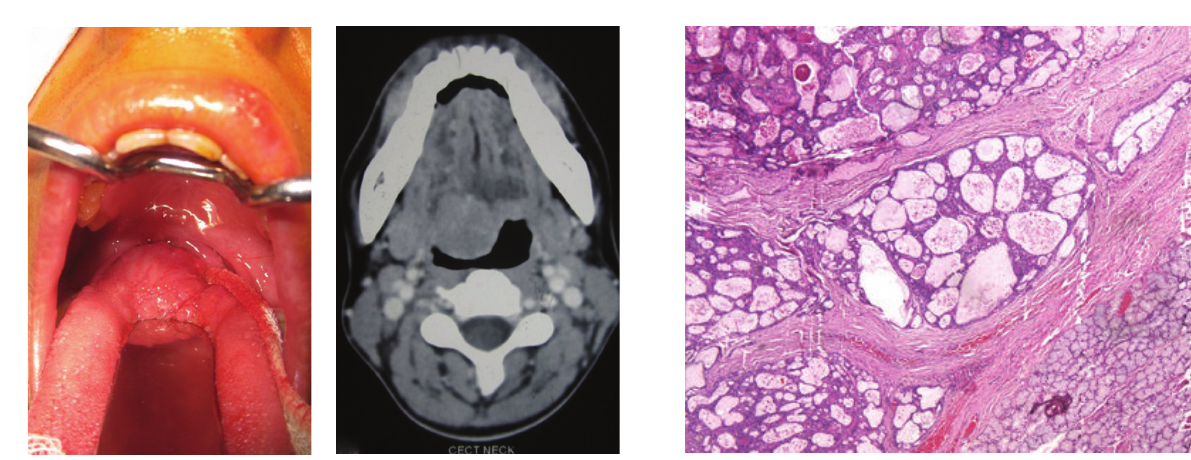
Figure 1: Figure showing the tumor in the base of tongue and the preoperative CT scan.